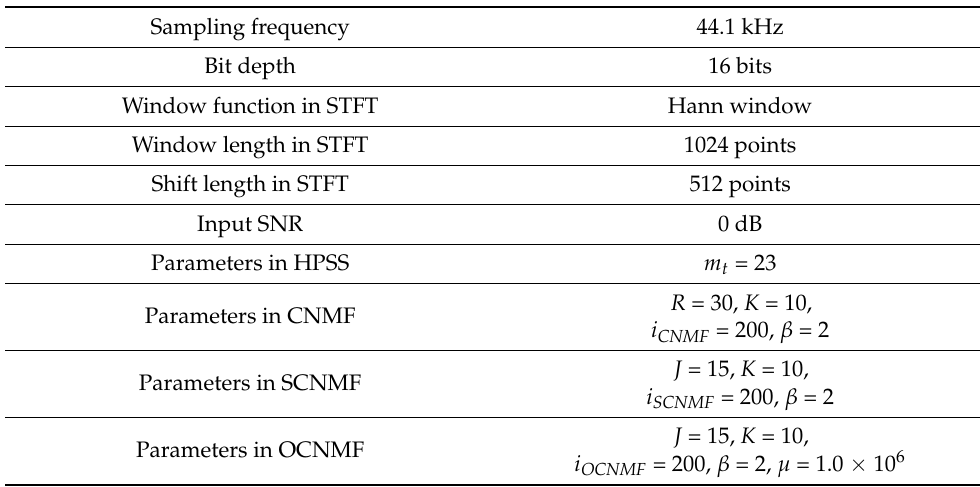
Table 3. Predetermined parameters in short-time Fourier transform (STFT), harmonic